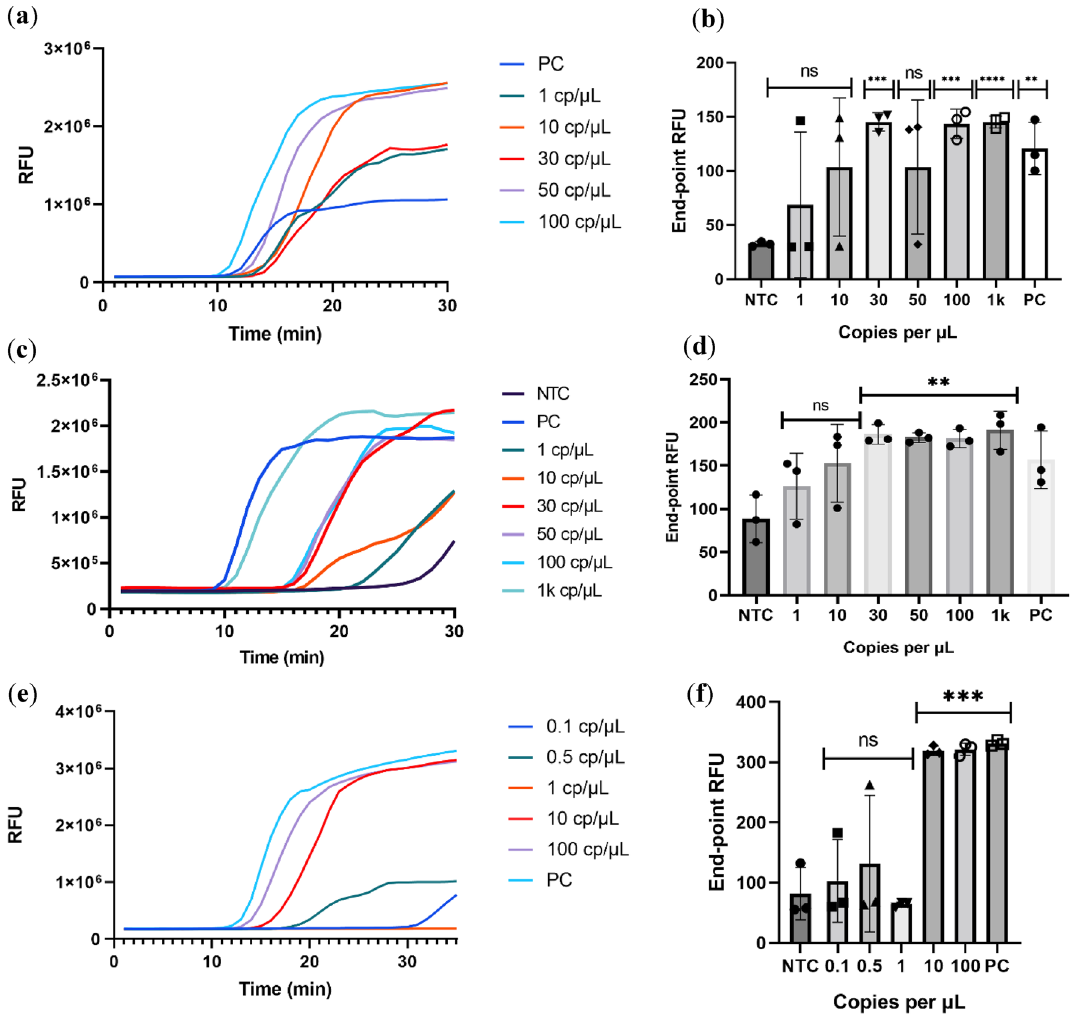
Figure 1. Real-time fluorescence for the NEB RT-LAMP reactions using the N/E primer set ( a ), the As1 primer set ( c ) and the N/E/As1 combined primer set ( e ). End point fluorescence measurements for the respective primer sets ( b ), ( d ) and ( f ). Statistical significance was determined by unpaired two-tailed t-test and all data were shown as mean ± S.D of 3 replicates. Asterisks indicate **P < 0.01; ***P < 0.001; ****P < 0.0001 and “ns” is